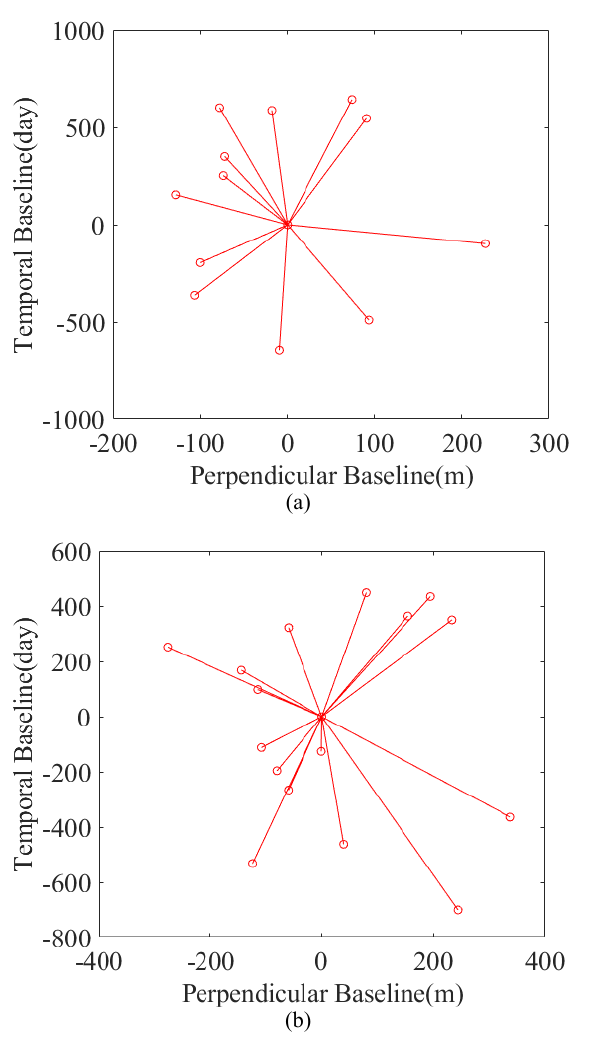
Figure 1. Geometric baselines of persistent scatterer interferometry (PSI) analysis (perpendicular baseline versus temporal baseline): (a) ascending data, (b) descending data